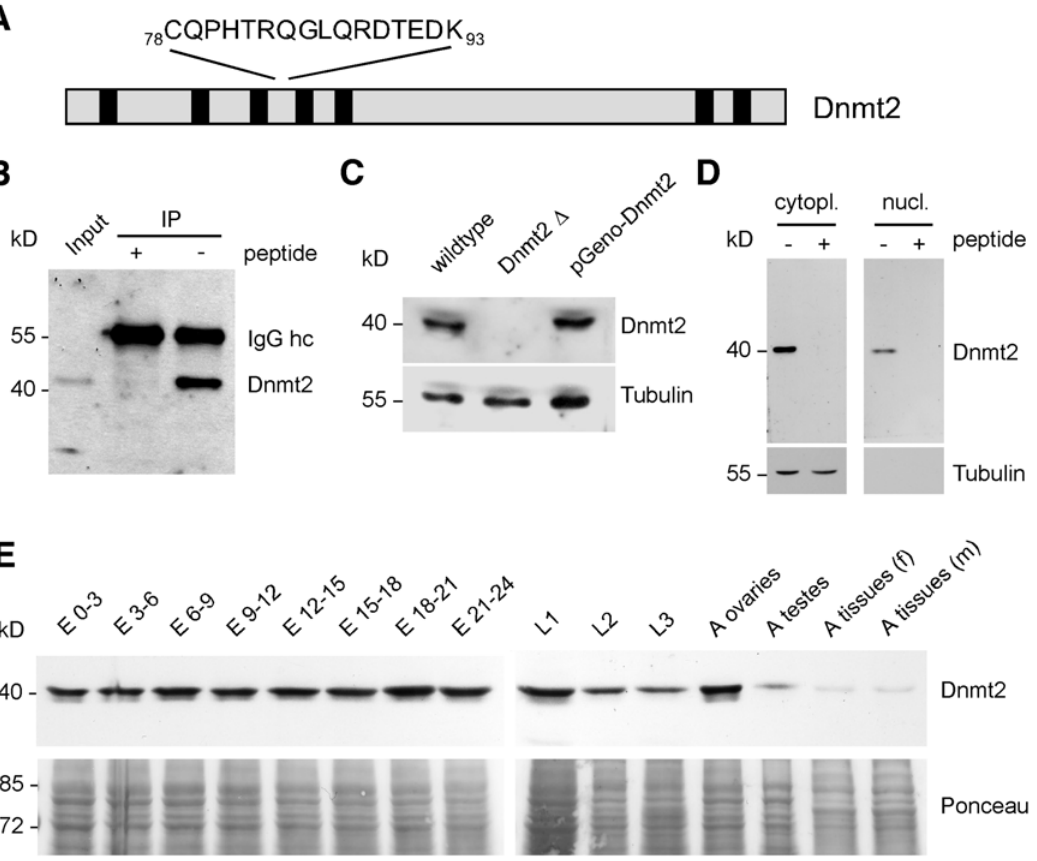
Figure 1. Establishment of Dnmt2-specific antibodies and characterization of Dnmt2 expression during Drosophiladevelopment. (A) Sequence of the epitope recognized by polyclonal antibodies against Dnmt2 peptide spanning amino acids 78–93. (B) Affinity-purified anti-Dnmt2 antibodies efficiently immunoprecipitate Dnmt2 from whole cell protein extracts. (C) Anti-Dnmt2 specifically detects a 40 kDa protein. Whole-cell protein extracts from wildtype, homozygous mutants (Dnmt2 D ) and rescued mutants (pGenoDnmt2) were blotted and probed with anti-Dnmt2. (D) Early embryonic tissue (0–6 hr AEL) was fractionated, blotted as cytoplasmic and nuclear fractions and probed with anti-Dnmt2 and anti- ^ -tubulin as control. (E) Developmental Western blot. Wildtype cytoplasmic protein extract from various embryonic, larval and adult stages were blotted and probed with anti-Dnmt2. Ponceau staining of blot is shown as loading control. hc-heavy chain, cytopl.-cytoplasmic, nucl.-nuclear, E-embryo, L1-first instar larvae, L2-second instar larvae, L3-third instar larvae, A-adult, f-female,